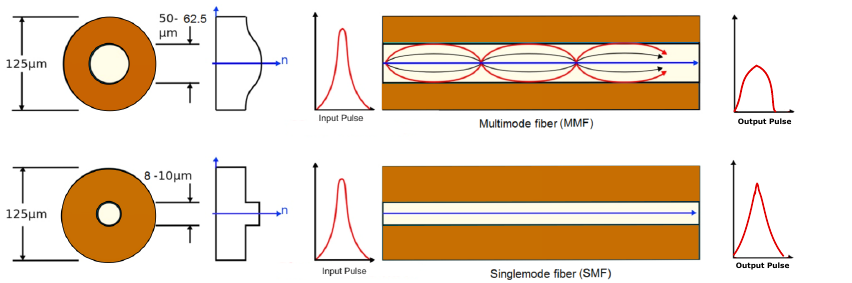
Figure 2. Schematic of light propagation in a singlemode versus multimode fiber (adapted from